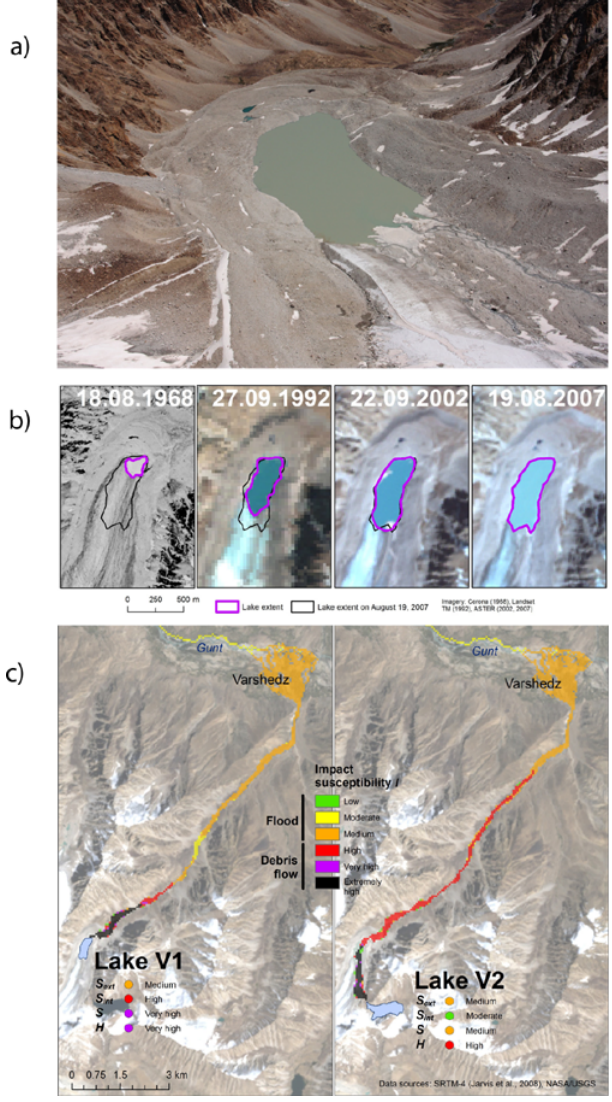
Fig. 9. Computed maximum travel distances of debris flows and floods from lake outbursts. Fig. 10. (a) Aerial view of Lake V1 (August 2009). (b) Devel-